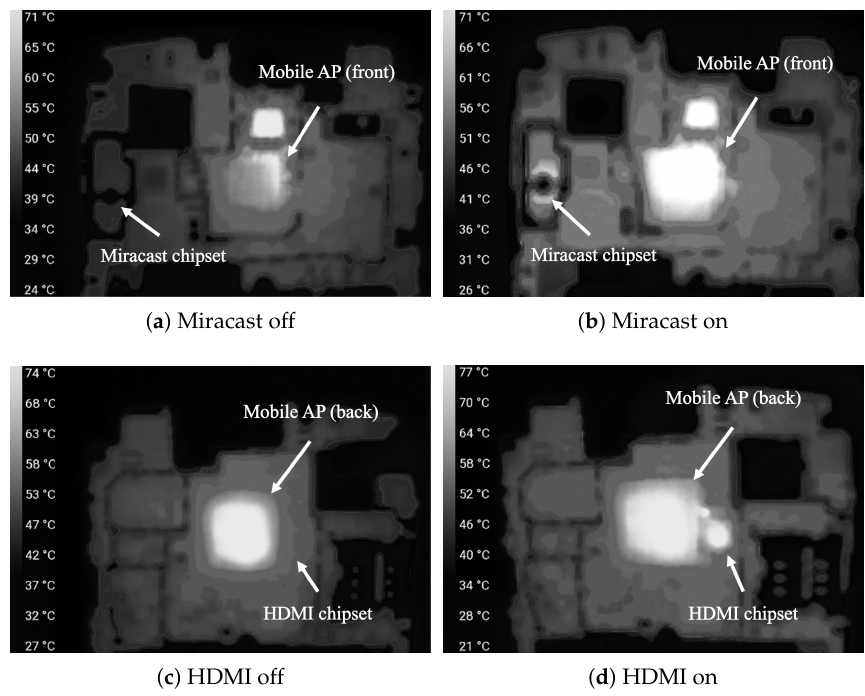
Figure 4. Comparison of surface temperatures of mobile AP (Application Processor), Miracast chipset, and HDMI (High Definition Multimedia Interface) chipset with and without Miracast and HDMI on smartphone.